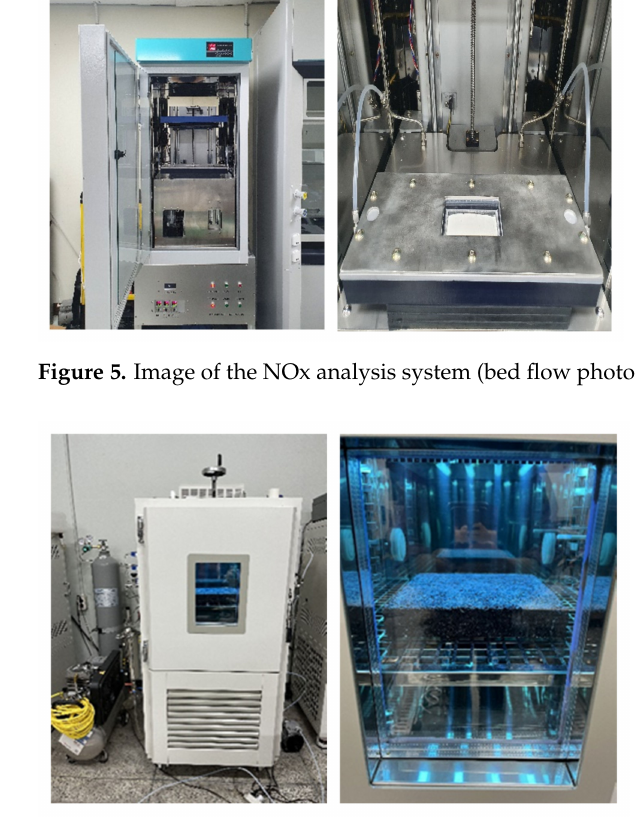
Figure 6. Image of the NOx analysis system (mixed tank photo